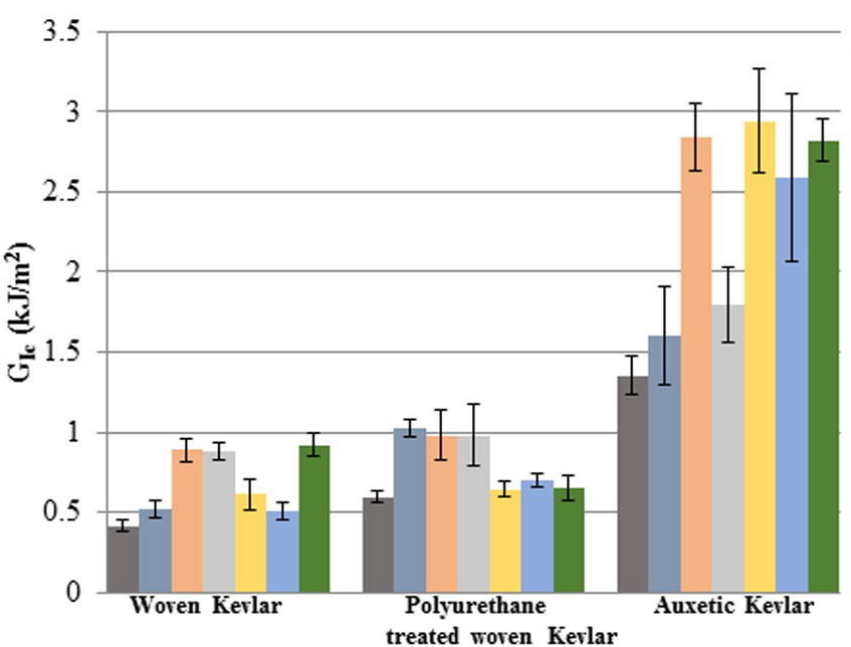
Figure 6. Fracture initiation toughness (G IC ) for all types of composites. Reprinted with permission from Ref. [97]. Copyright 2017,